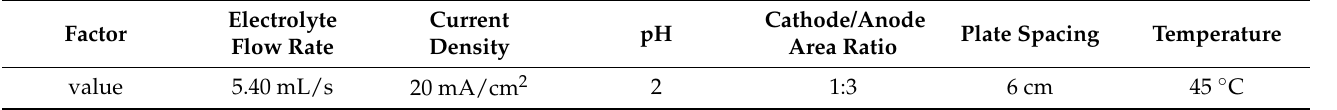
Table 2. The experimental conditions obtained after